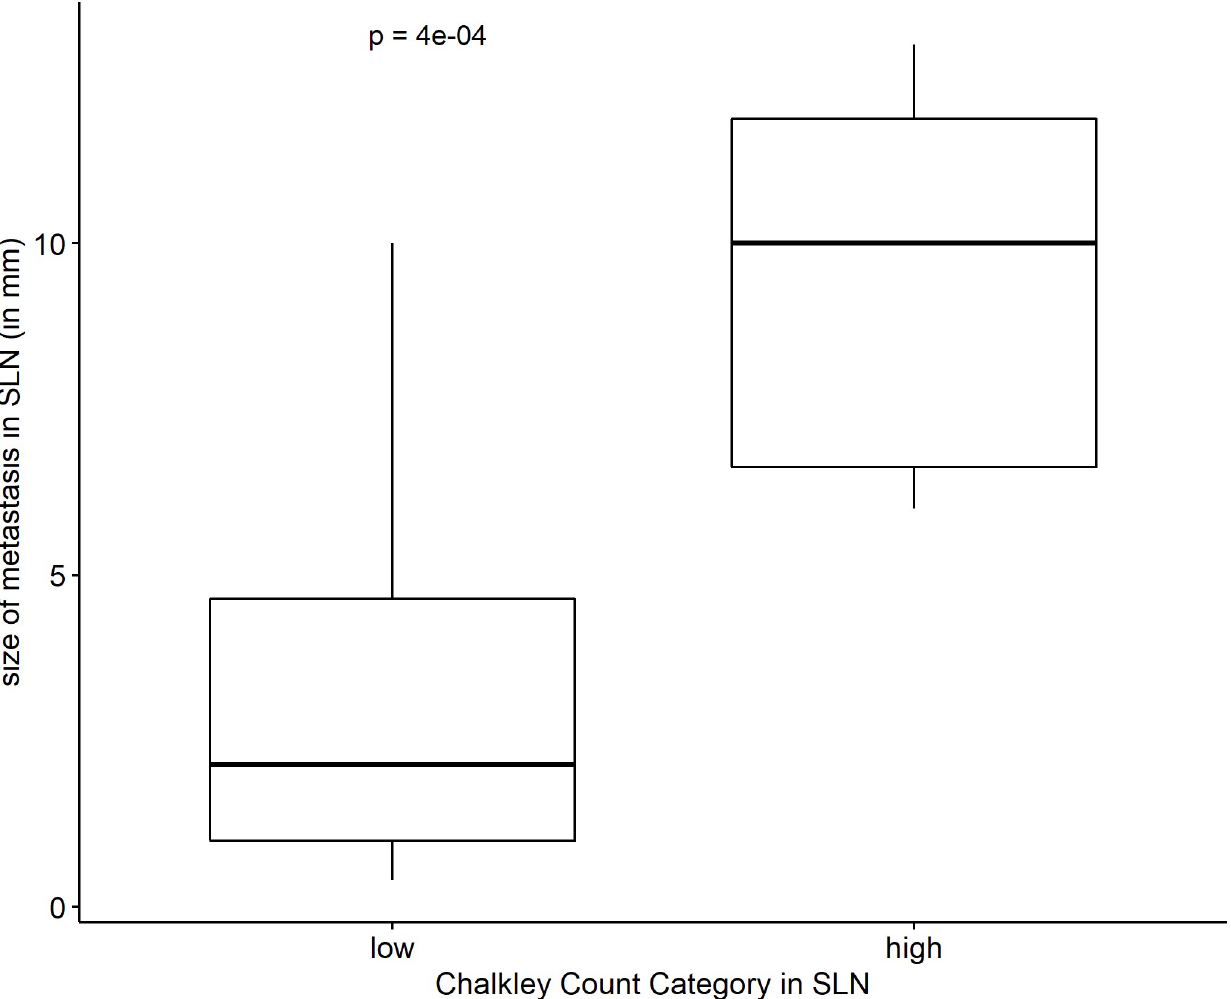
Fig 3. Correlation of the number of lymphatic vessels with the size of metastasis in SLN. The number of lymphatic vessels in SLN metastases was calculated and categorized on the basis of the median in two categories, high and low. Here, a box plot displays the Chalkley count category with respect to the size of SLN metastasis in millimeters. The box signifies the first to third quartile with the median as bar. The line indicates all values with the ends representing minimum and maximum values.